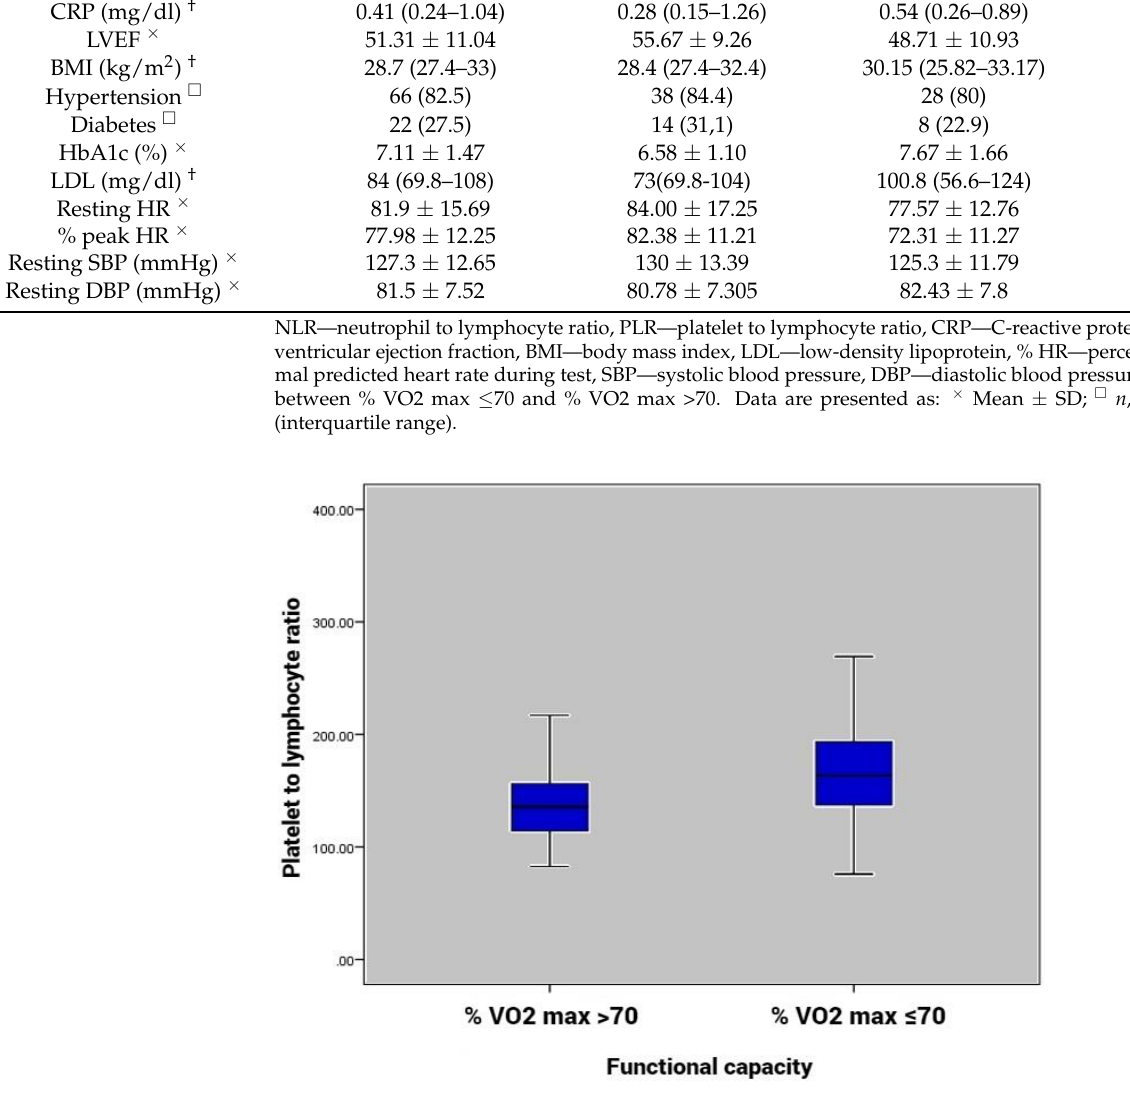
Figure 2. Platelet to lymphocyte ratio levels according to functional capacity groups. PLR were positively correlated with % VO2 max ( p < 0.05; Table 2). NLR was associated with PLR, but not with the analyzed CPET parameters. In a logistic multivariate model, the PLR remained significant predictor of poor FC (Table 3). NLR was not a significant predictor of poor FC in univariate analysis; thus, it was not included in the multivariable regression